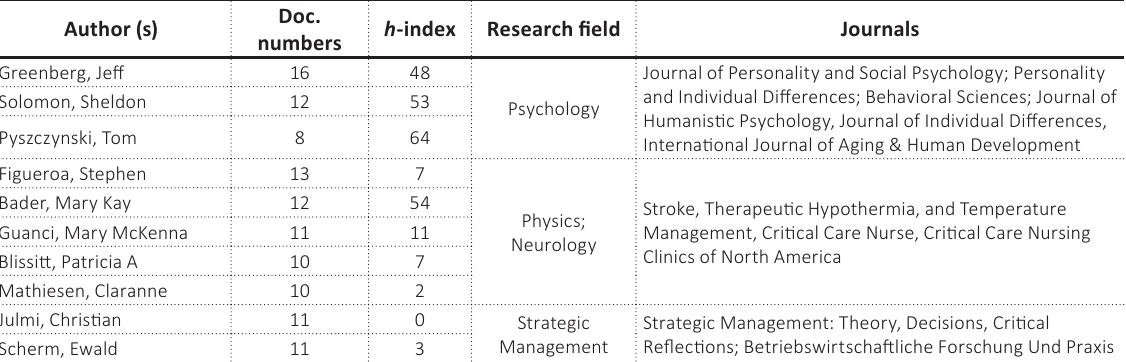
Table 3. Authors with the largest number of